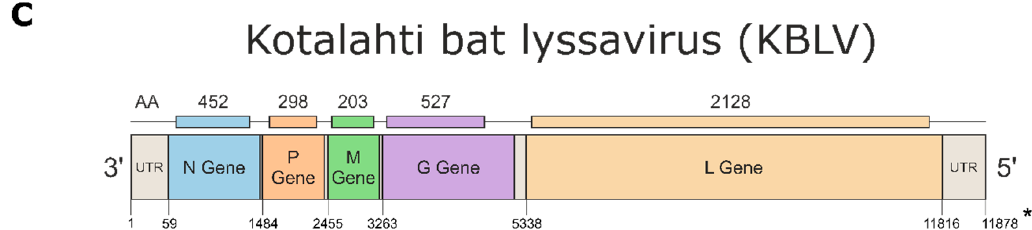
Figure 1. ( A ) ML-Phylogenetic tree based on full-genome sequences of representatives of the 17 different lyssavirus species and their respective affiliation to one of the four designated phylogroups (I-IV) ( B ) Enlarged part of the tree showing the lyssaviruses most closely related to KBLV and the bat species they were isolated from; ( C ) The 11,878 nt long sequence of the Kotalahti bat lyssavirus (KBLV) genome reflects the characteristic gene organization known for lyssaviruses encoding for the five viral proteins: nucleoprotein (N), phosphoprotein (P), matrix protein (M), glycoprotein (G) and the RNA-dependent RNA polymerase (L). * Sequence depth of the 5 ′ UTR was not sufficient at the final part to verify nucleotides.